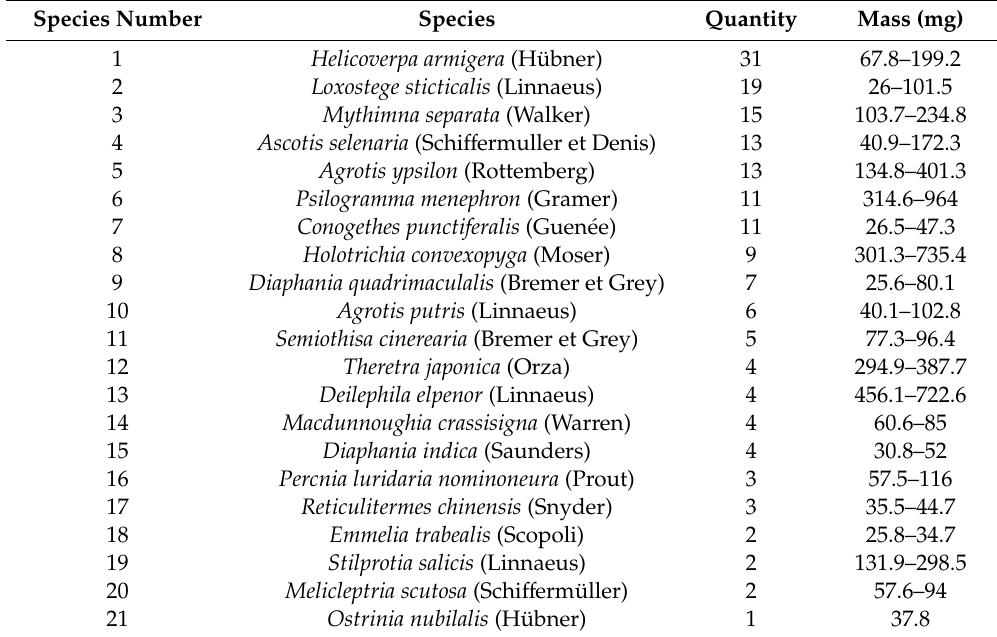
Table 1. Species and mass of experimental insects.